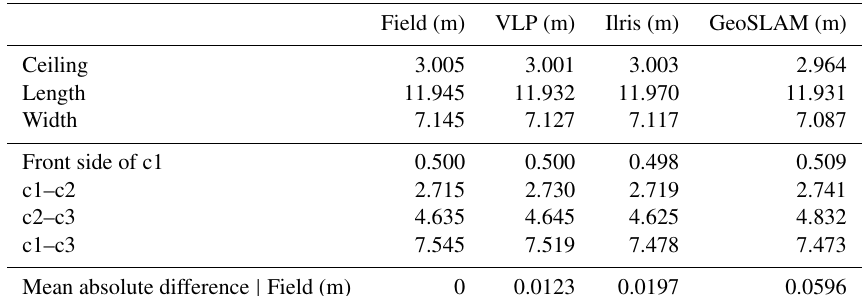
Table 6. Comparison of field and lidar measurements (see Fig. 4). Vertical line stands for “in comparison with”.